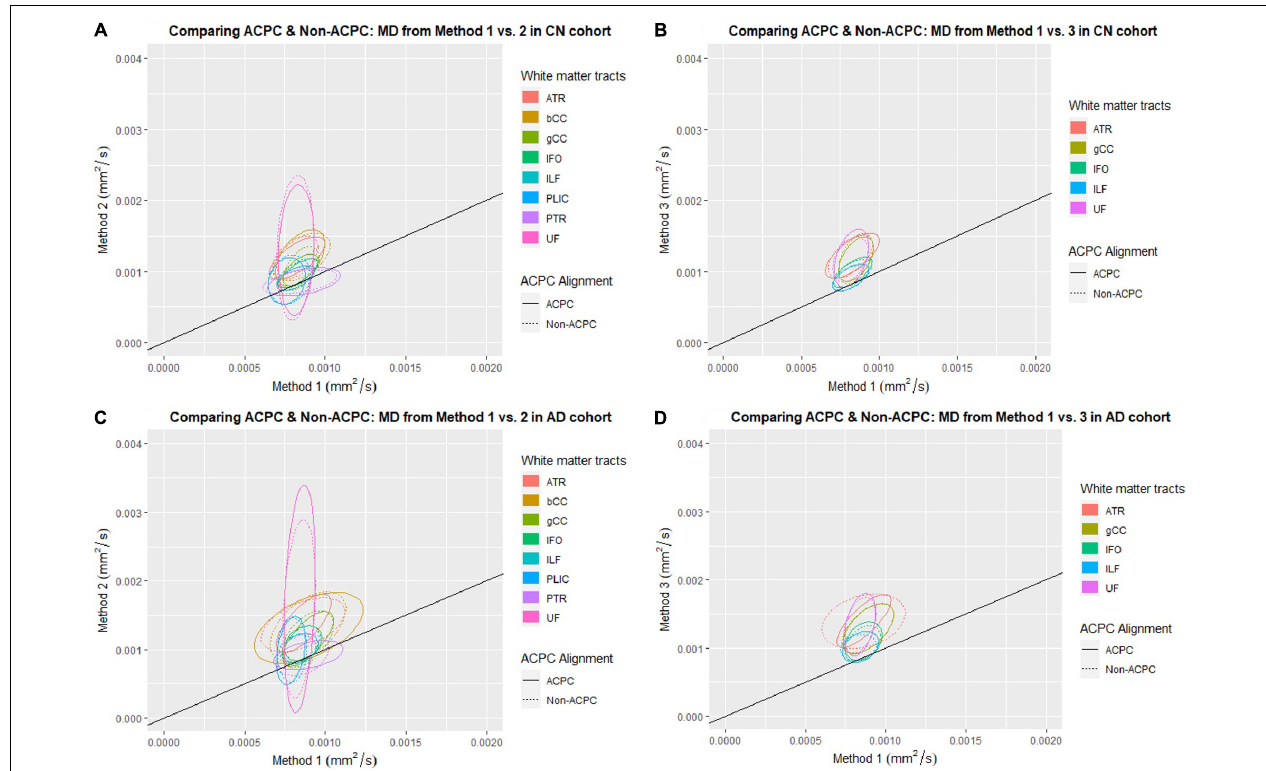
FIGURE 2 | Distribution of scatter plots of MD obtained using Methods 2 and 3 against Method 1, comparing non-ACPC aligned and co-registered with ACPC aligned white matter tracts across cognitively normal (CN) and Alzheimer’s Disease (AD) cohorts. The ellipses assume a multivariate normal distribution with the mean at the center and area of the ellipse representing 95% confidence level. gCC, genu of the corpus callosum; bCC, body of the corpus callosum; ATR, anterior thalamic radiation; IFO, inferior fronto-occipital fasciculus; ILF, inferior longitudinal fasciculus; PLIC, posterior limb of the internal capsule; PTR, posterior thalamic radiation; UF, uncinate fasciculus. (A) Comparing ACPC and Non-ACPC: MD from Method 1 vs. 2 in CN cohort. (B) Comparing ACPC and Non-ACPC: MD from Method 1 vs. 3 in CN cohort. (C) Comparing ACPC and Non-ACPC: MD from Method 1 vs. 2 in AD cohort. (D) Comparing ACPC and Non-ACPC: MD from Method 1 vs. 3 in AD